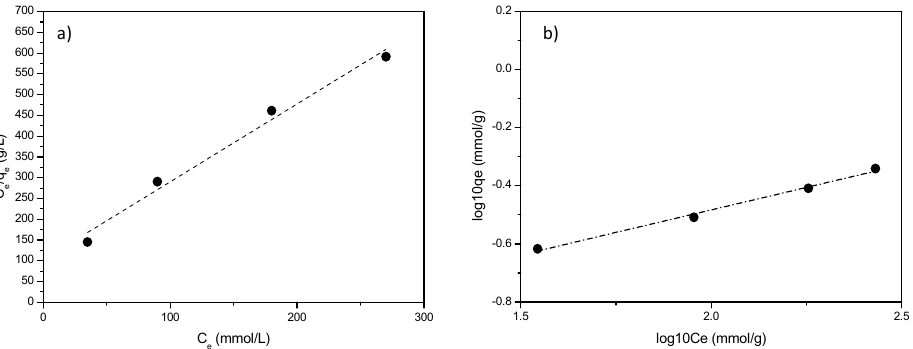
Figure 8. Adsorption isotherms for L6-STx: ( a ) Langmuir and ( b ) Freundlich model.